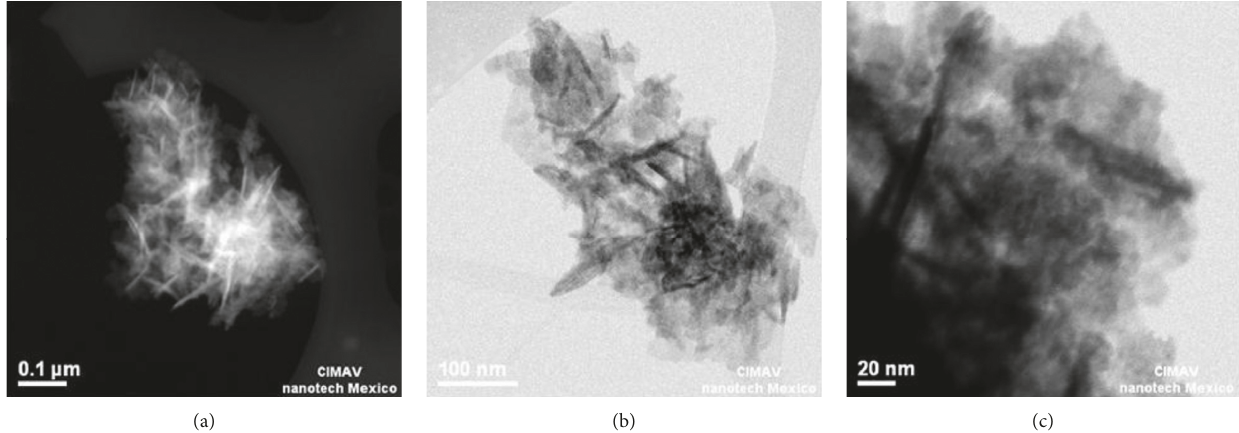
Figure 2: HRTEM images showing materials synthesized using 0.324 g of PVP. These different three particles shown at (a), (b), and (c) support the assumption that the morphology is a general characteristic of all the materials and not only a particular